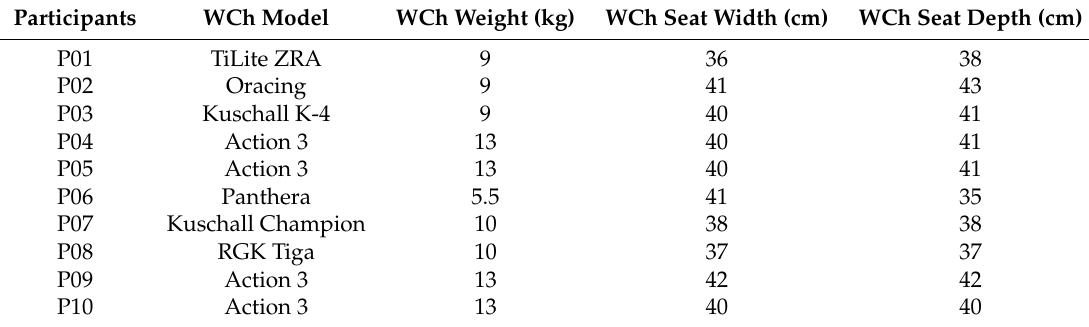
Table 2. Characteristics of the wheelchairs (WCh) of the